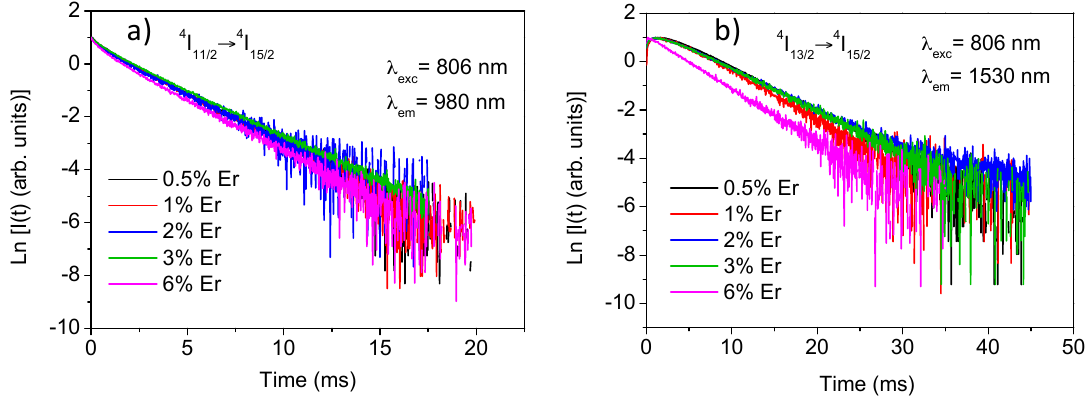
Figure 2. Semilogarithmic plot of the experimental decays of the 4 I 11/2 ( a ) and the 4 I 13/2 ( b ) levels for all samples obtained under excitation at 806 nm. Table 1. Lifetimes of the 4 I 9/2 , 4 I 11/2 , and 4 I 13/2 levels obtained under excitation at 806 nm at room temperature. ( λ em is the emission